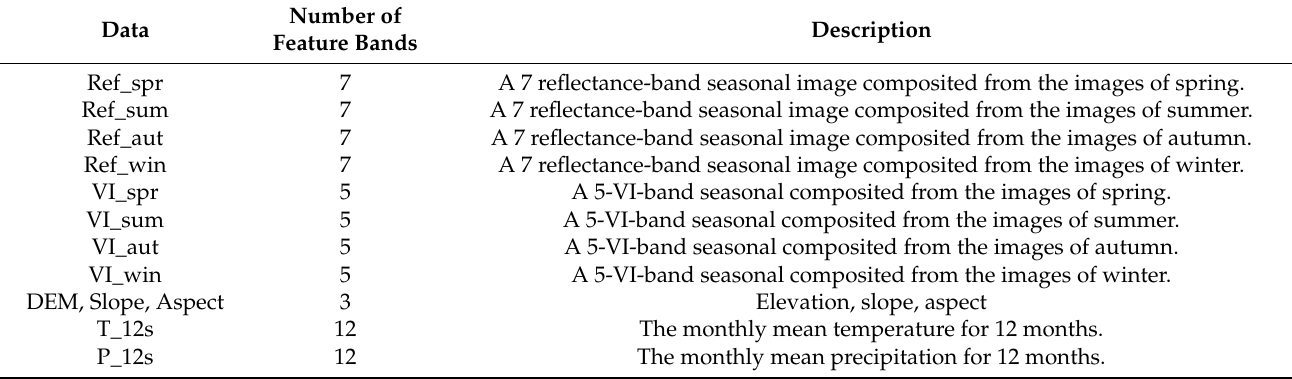
Table 5. Features, including four seasonal of spectral reflectance images and four seasonal vegetation index images, three terrain factors, temperature, and precipitation in 12 months, used in the research.